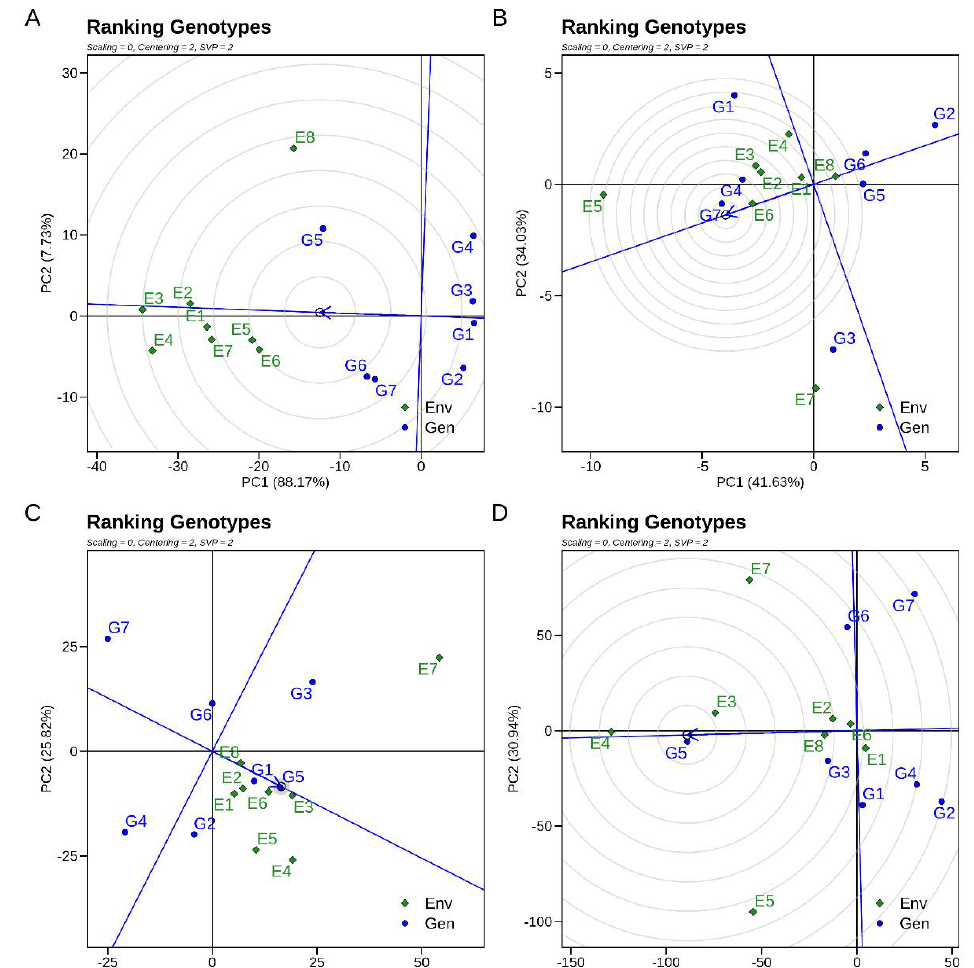
Figure 4. The GGE biplot ‘Ranking genotypes’ pattern to rank genotypes for the ideal genotype of 5 GSR lines and 2 control lines grown under eight environments in the year 2020 for ( A ) plant height, ( B ) the number of tillers, ( C ) grain yield, and ( D ) straw yield. The biplots were created with centering = 0, SVP = 2, and scaling = 0 parameters.